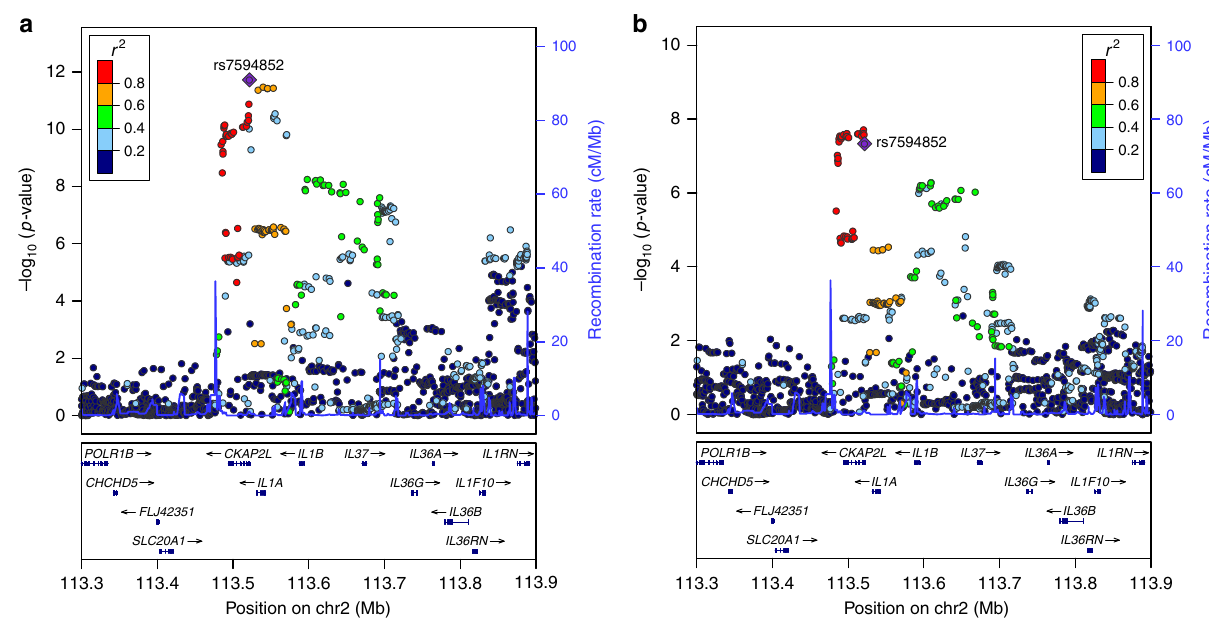
Fig. 1 Discovery stage results at the 2q13 locus. Regional association plots for a gestational duration and b postterm birth. SNP position is shown on the x - axis and association ( − log10 P value) with gestational duration and postterm birth, respectively, on the left y -axis. The lead SNP, rs7594852, from the gestational duration analysis is represented by a purple diamond, and the other SNPs are colored to re fl ect their LD with the lead SNP (based on pairwise r 2 values from the Danish National Birth Cohort). In the postterm birth analysis, rs7607470 had a slightly lower P value, but this SNP is highly correlated with rs7594852 ( r 2 > 0.99), and the latter SNP was selected for the replication stage analyses of both gestational duration and postterm birth. Estimated recombination rates are from HapMap (right y -axis)